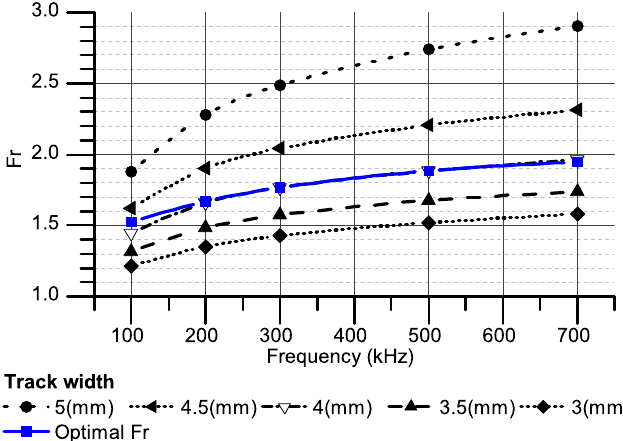
Figure 12. R AC / R DC of ten-turn PCB windings with different track